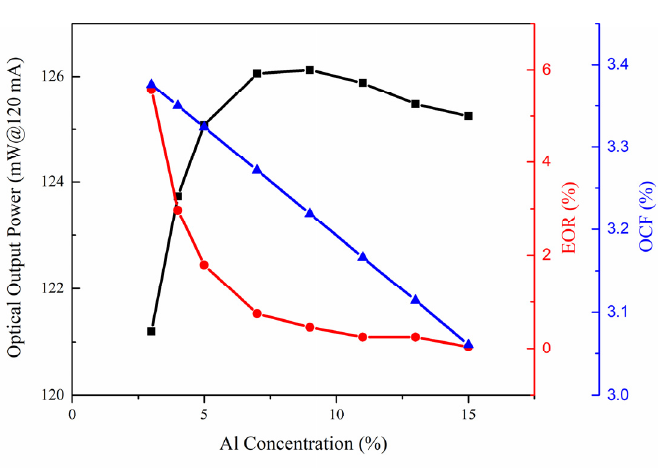
Figure 3. Simulated optical output power (black), electron overflow rate (red) and optical confinement factor (blue) at injecting current of 120 mA versus different Al composition in CLQB of LD series I.